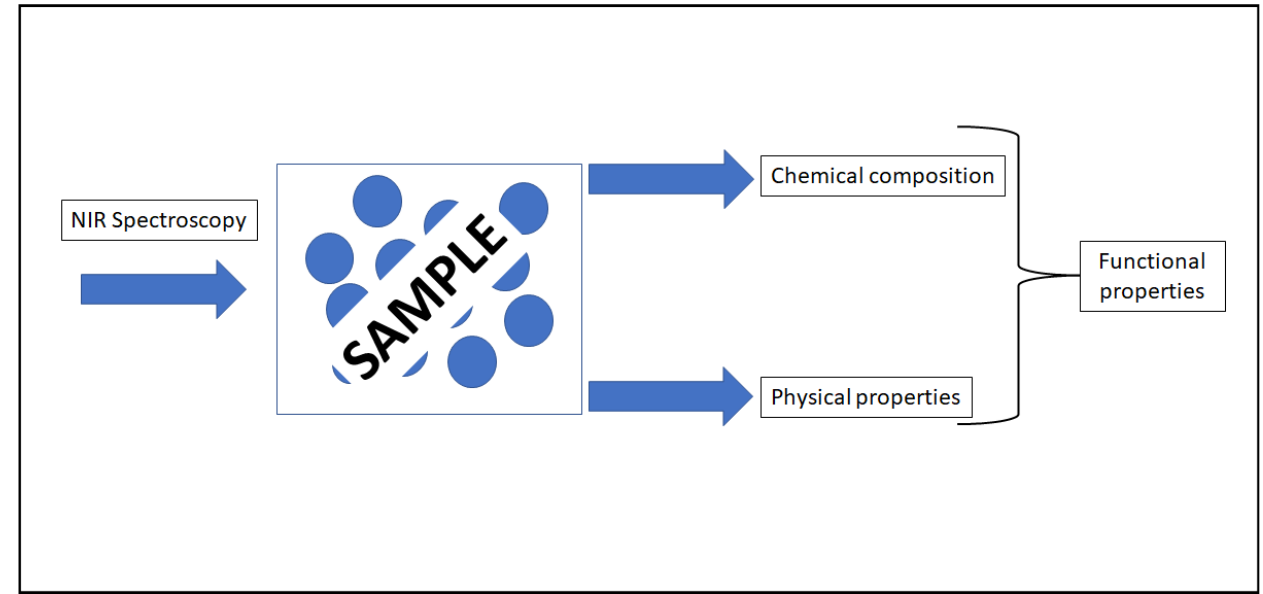
Figure 1. The utilization of near infrared spectroscopy to measure chemical and physical properties in foods.